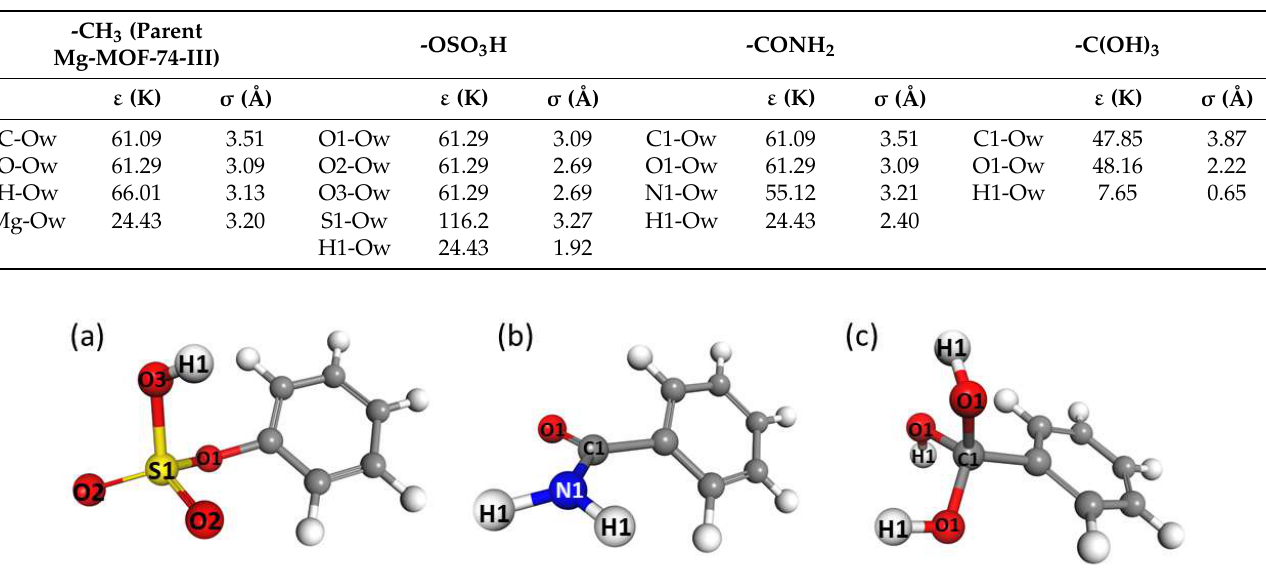
Figure 5. The different atom types of the atoms of the functional groups that were considered in the force field fitting procedure, ( a ) -OSO 3 H, ( b ), -CONH 2 and ( c ) -C(OH) 3 .